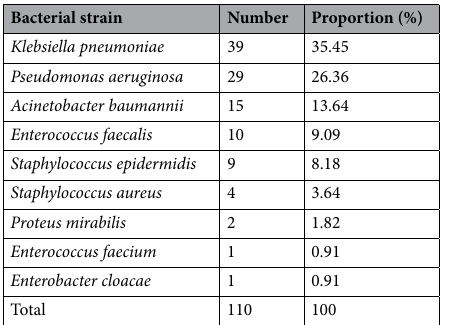
Table 1. Composition ratio of bacteria detected in blood